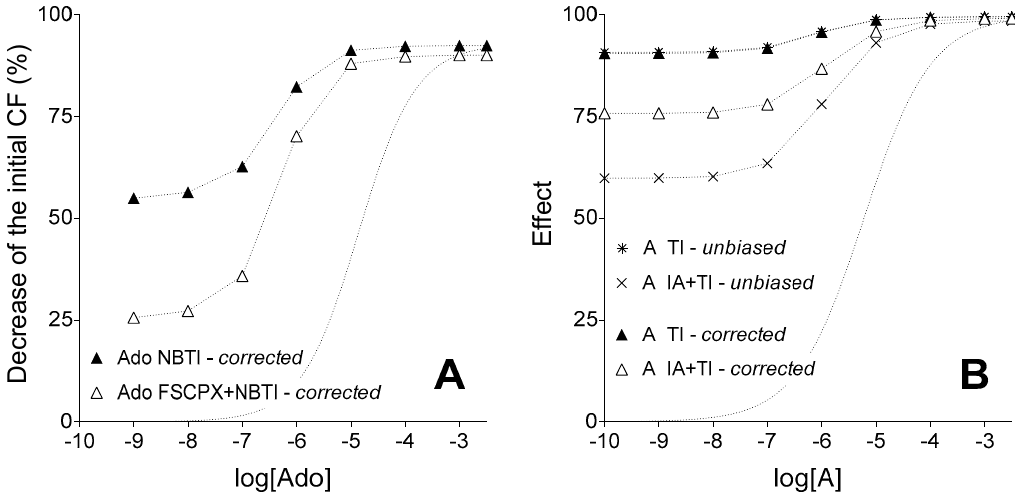
Figure 4. Ex vivo biological (panel A ) and in silico simulated (panel B ) models showing corrected E/c curves of an agonist with a short half-life, in the absence and presence of an agonist transport inhibitor, acting in systems with unaffected (filled symbols) and reduced (open symbols) receptor number (while symbols of the built-in in silico control curves labelled as “unbiased” are simply x and asterisk). The x -axis denotes the common logarithm of the molar concentration of agonists (in the bathing medium), and the y -axis indicates the effect. The dotted lines between symbols only connect them, while the dotted lines without symbols represent the Hill equation fitted to data of the control adenosine E/c curve (panel A) and the simple unbiased E/c curve of agonist A generated upon naïve receptor population (panel B). Ado: adenosine; NBTI: a treatment with S-(2-hydroxy-5-nitrobenzyl)-6-thioinosine; FSCPX: a prior treatment with 8-cyclopentyl- N 3 -[3-(4-(fluorosulfonyl)benzoyloxy)propyl]- N 1 -propylxanthine; A: agonist A (simulating adenosine); TI: a treatment with an inhibitor of agonist A transport (simulating the presence of NBTI); IA: a prior treatment with an irreversible antagonist (simulating an FSCPX pretreatment); unbiased : unbiased E/c curves of agonist A (control functions for the corresponding corrected E/c curves); corrected : E/c curves corrected with our method; CF: contractile force. Data of panel A are redrawn from [31].